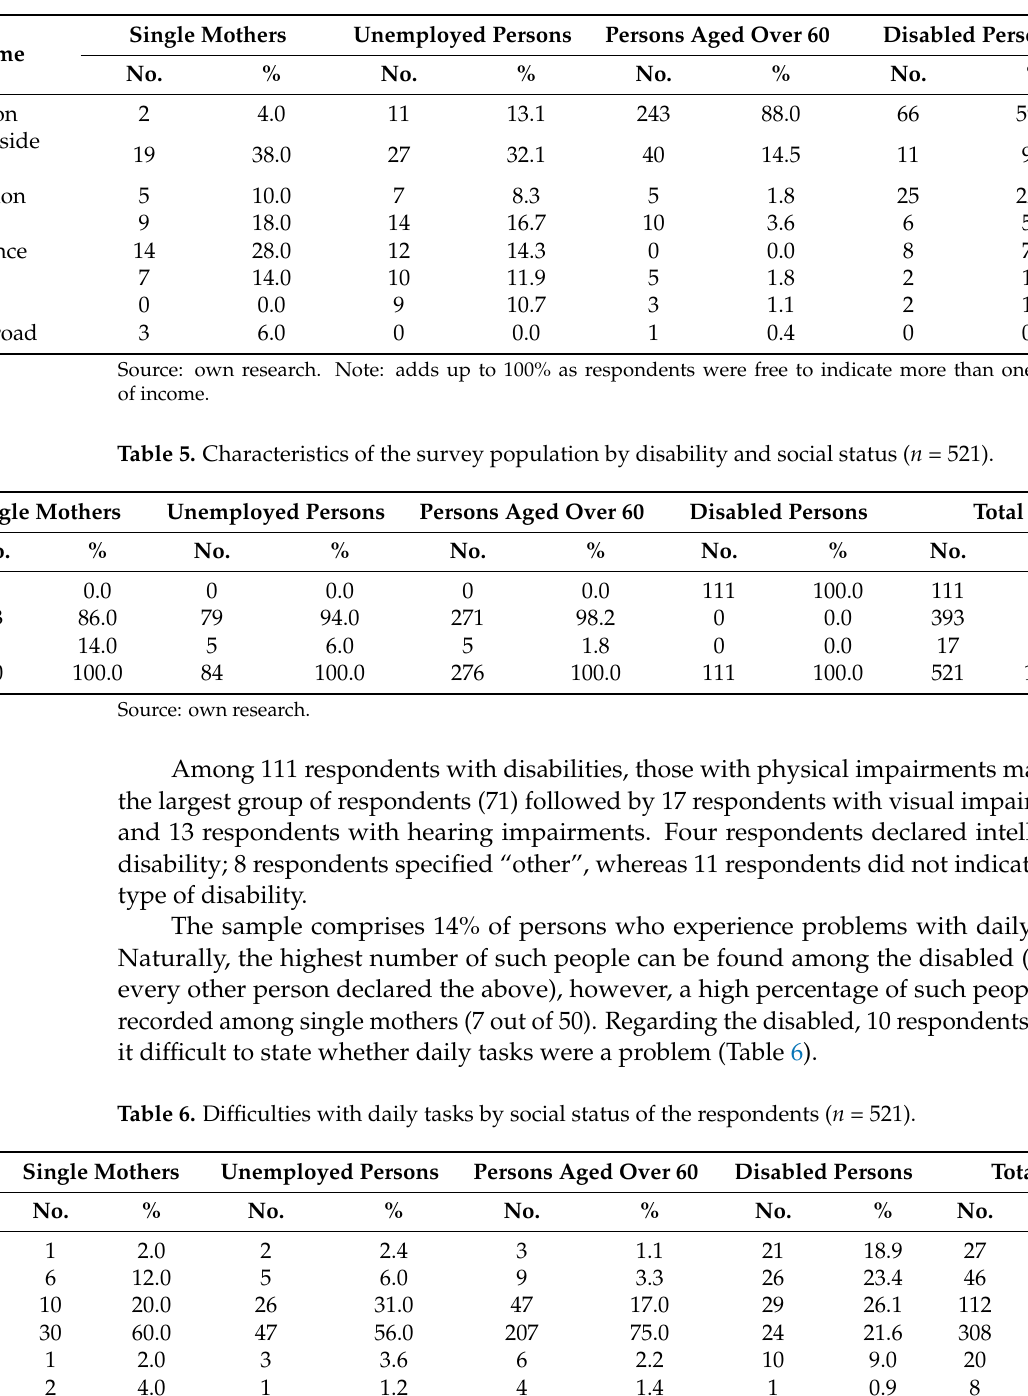
Table 4. Characteristics of the survey population by sources of income and social status ( n = 521).